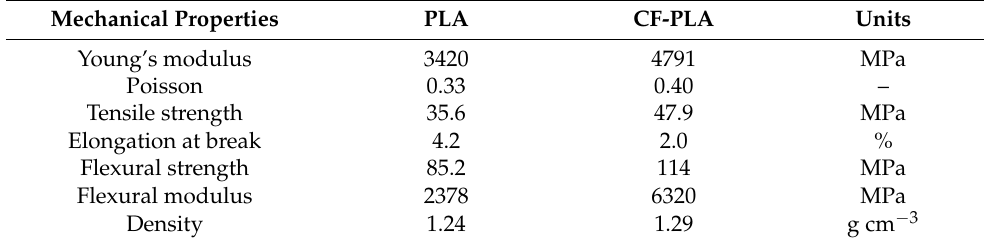
Figure 2. Prusa ® 3D printer. Table 2. The 3D printing parameters. Parameter